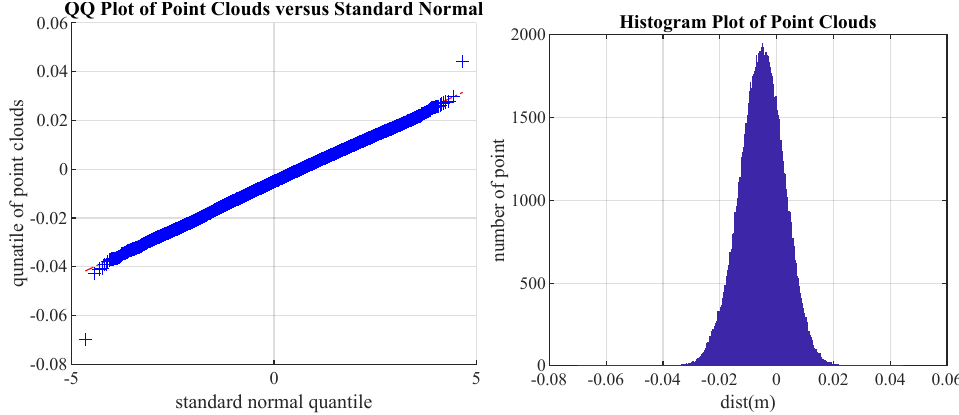
Figure 3. Quantile–Quantile Plot ( Left ) and Histogram ( Right ) of distances between points and measured